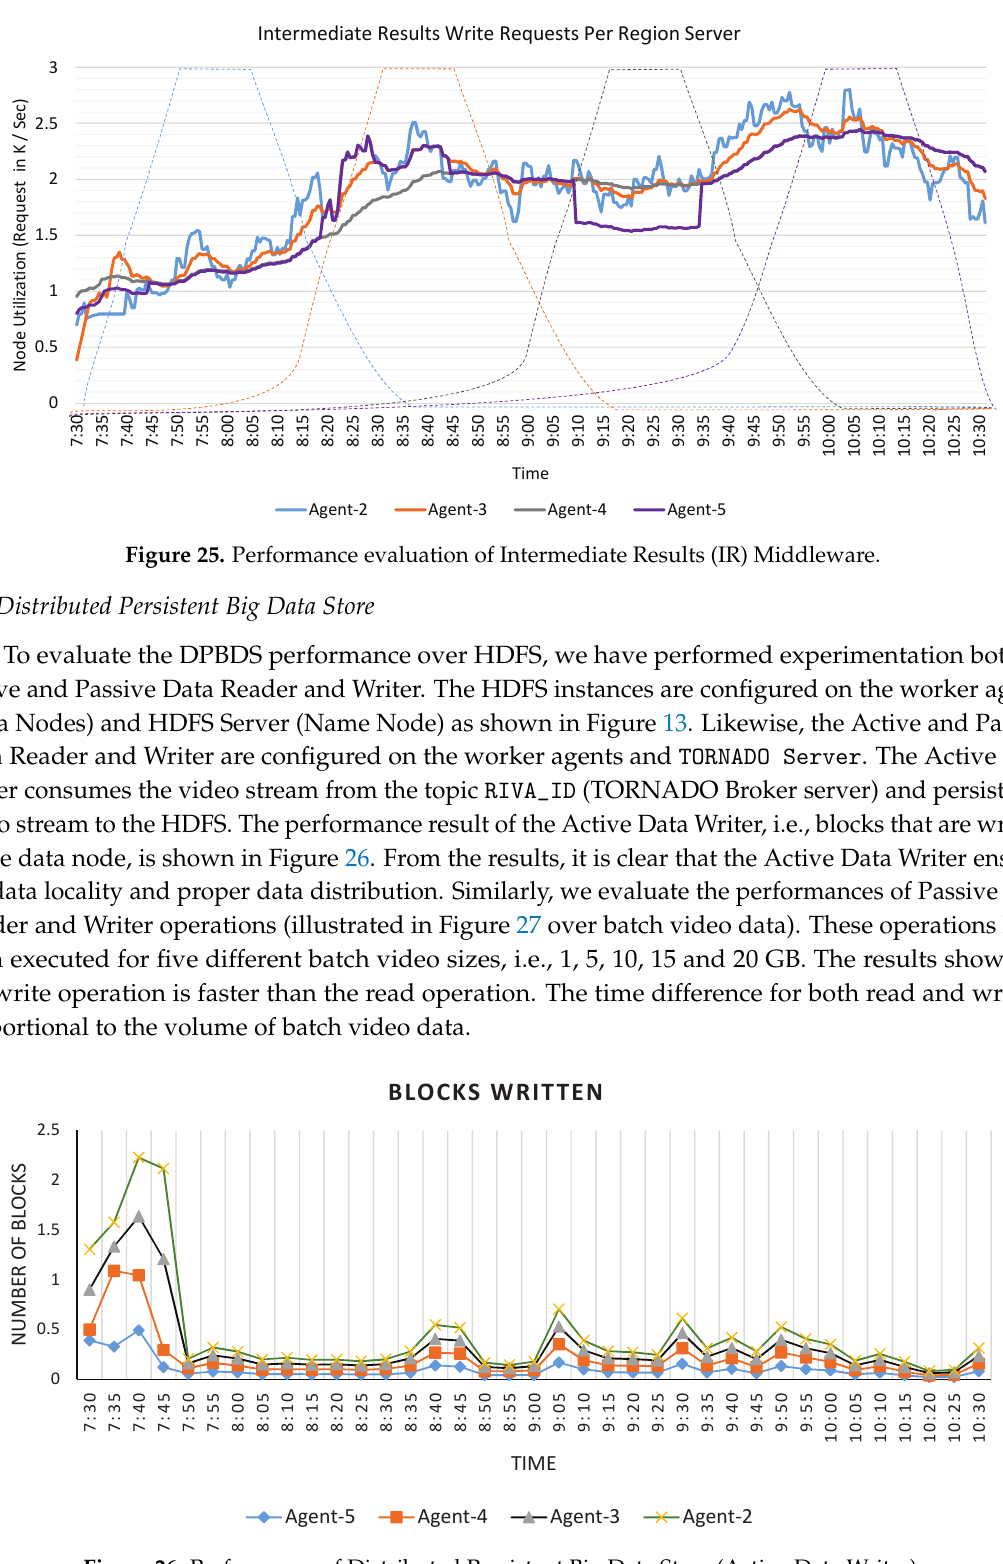
Figure 26. Performance of Distributed Persistent Big Data Store (Active Data